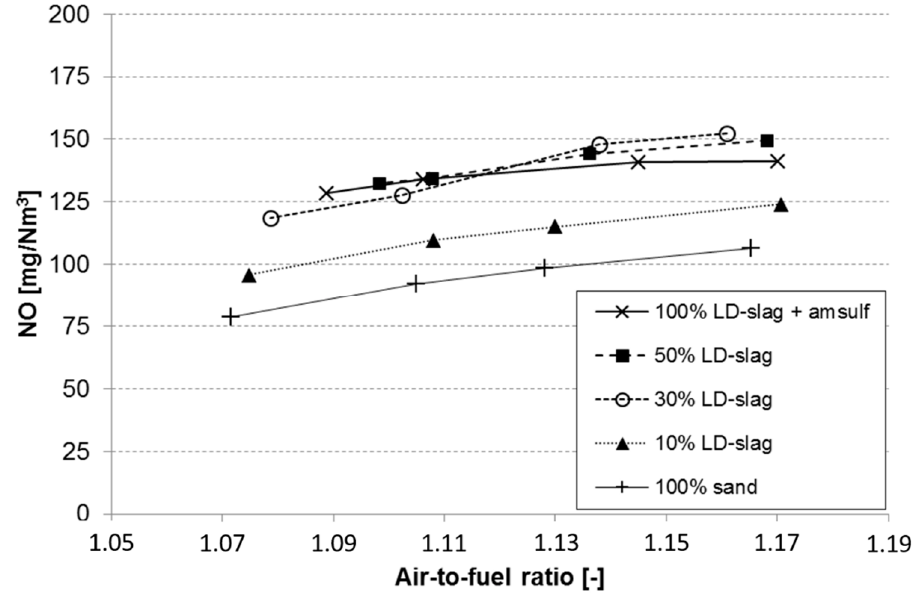
Figure 7. Measured concentrations of NO (mg/Nm 3 , at 6% O 2 ) at position kh2 in the convection path as a function of the air-to-fuel ratio.